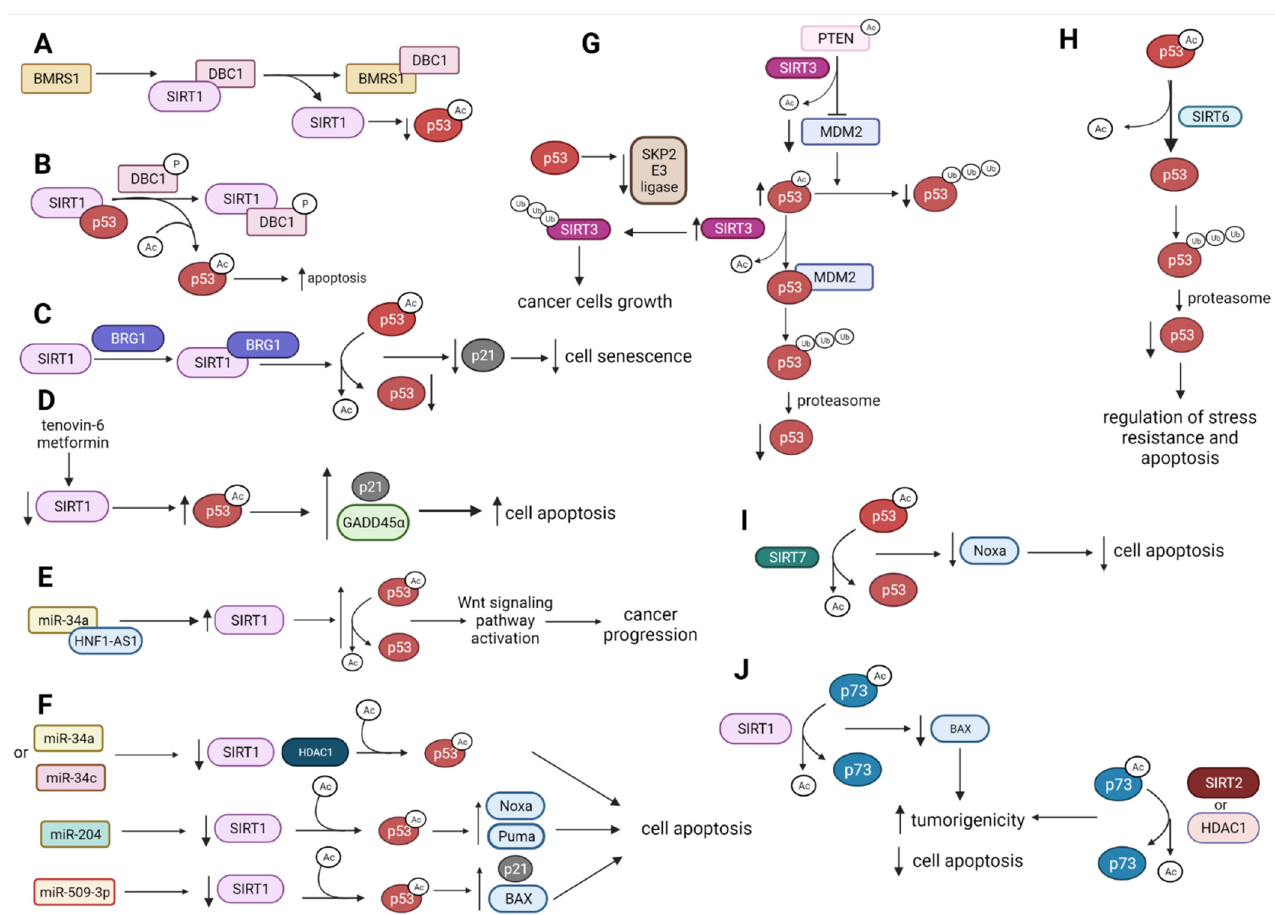
Figure 2. The biological effects of the p53-Ac and p73-Ac deacetylation catalyzed by SIRTs and HDACs. ↑ —upregulation, ↓ —downregulation ( A ) BMRS1 disrupts the interaction between SIRT1 and DBC1, decreasing the p53-Ac level. ( B ) Phos- phorylated DBC1 binds to SIRT1 that dissociates the SIRT1–p53 complex and simulates p53 acetylation leading to apop-